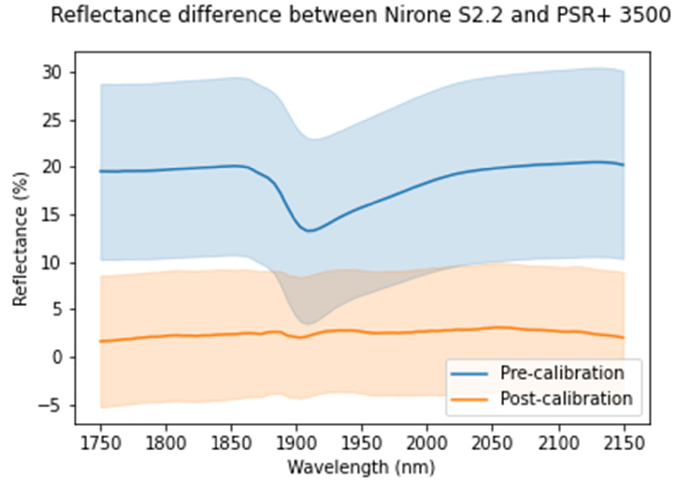
Figure 11. Difference between the in situ spectra and their transformation to laboratory reference spectral values (average reflectance and 95% confidence interval).